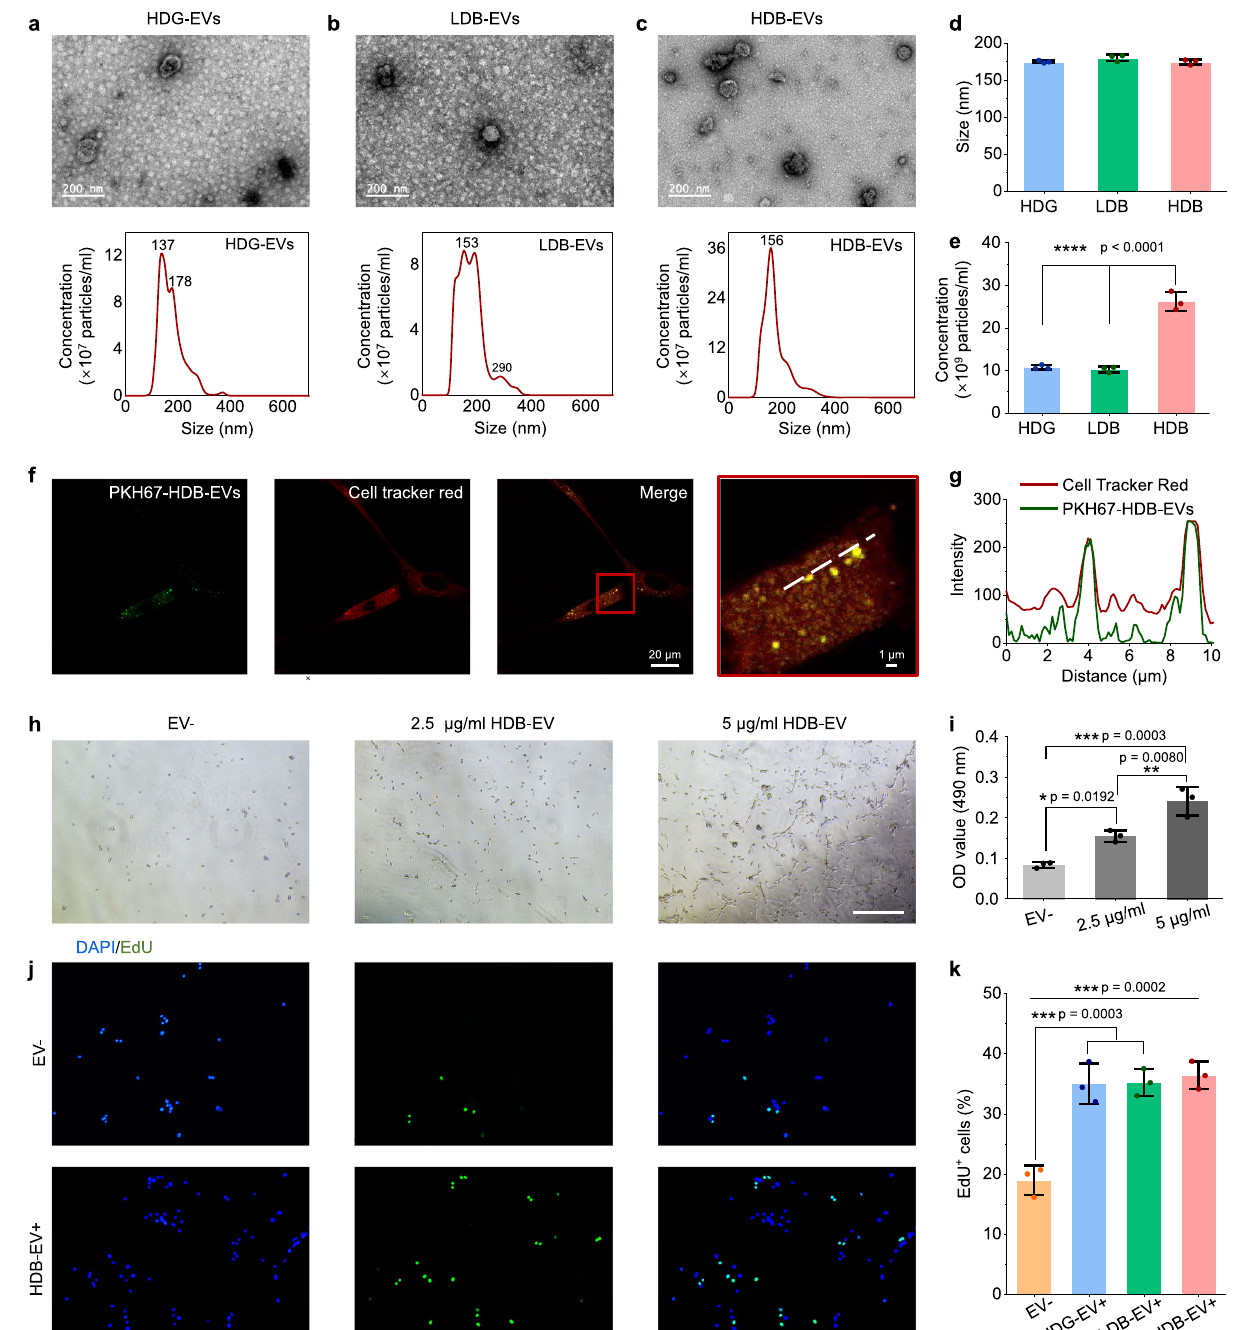
Fig. 5 | Matrigel HDB group augments MSCs production of extracellular vesi- cles (EVs). a – c Transmission electron microscopy (TEM) images and nanoparticle tracking analysis (NTA) of HDG-EVs ( a ), LDB-EVs ( b ), and HDB-EVs ( c ). Scale bars, 200nm. d and e The size (mean diameter) ( d ) and particle concentration ( e ) of HDG-EVs, LDB-EVs and HDB-EVs. n =3. f Colocalization between HDB-EVs and C2C12cells.PKH67-labeledHDB-EVswereincubatedwithC2C12for48h.Cellswere stained with Dil cell membrane tracker. g Intensity pro fi les of two fl uorescent channels (green, EVs; red, cell membrane) along the dashed line. h and